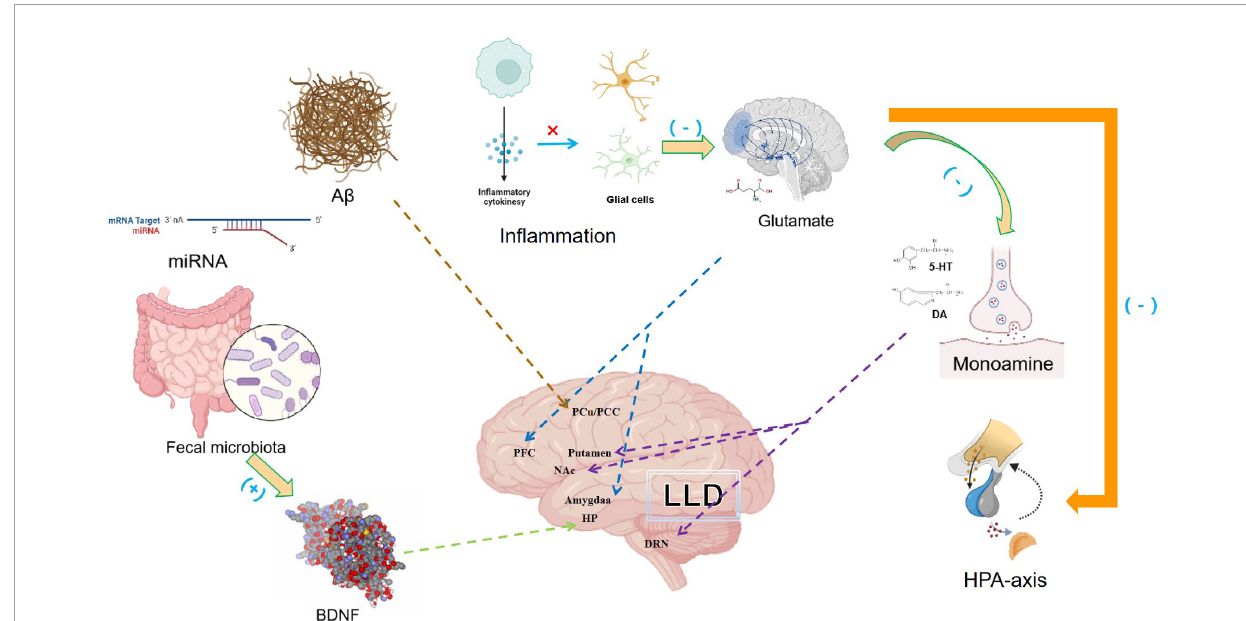
FIGURE2 The multiple pathogenesis of late-life depression (LLD) include insufficient monoamine neurotransmission, increased inflammation, abnormal glutamate input, decreased neurotrophic factor production, the dysregulation of the hypothalamus-pituitary-adrenal (HPA) axis, age-related A β deposition and low diversity of the gut microbiome. The interplay between the different pathogenesis of LLD and the partial localization of some of the mechanisms in the brain was also shown. Pro-inflammatory cytokines can dysregulate the glutamate system, reduces the synthesis of serotonin and affect HPA